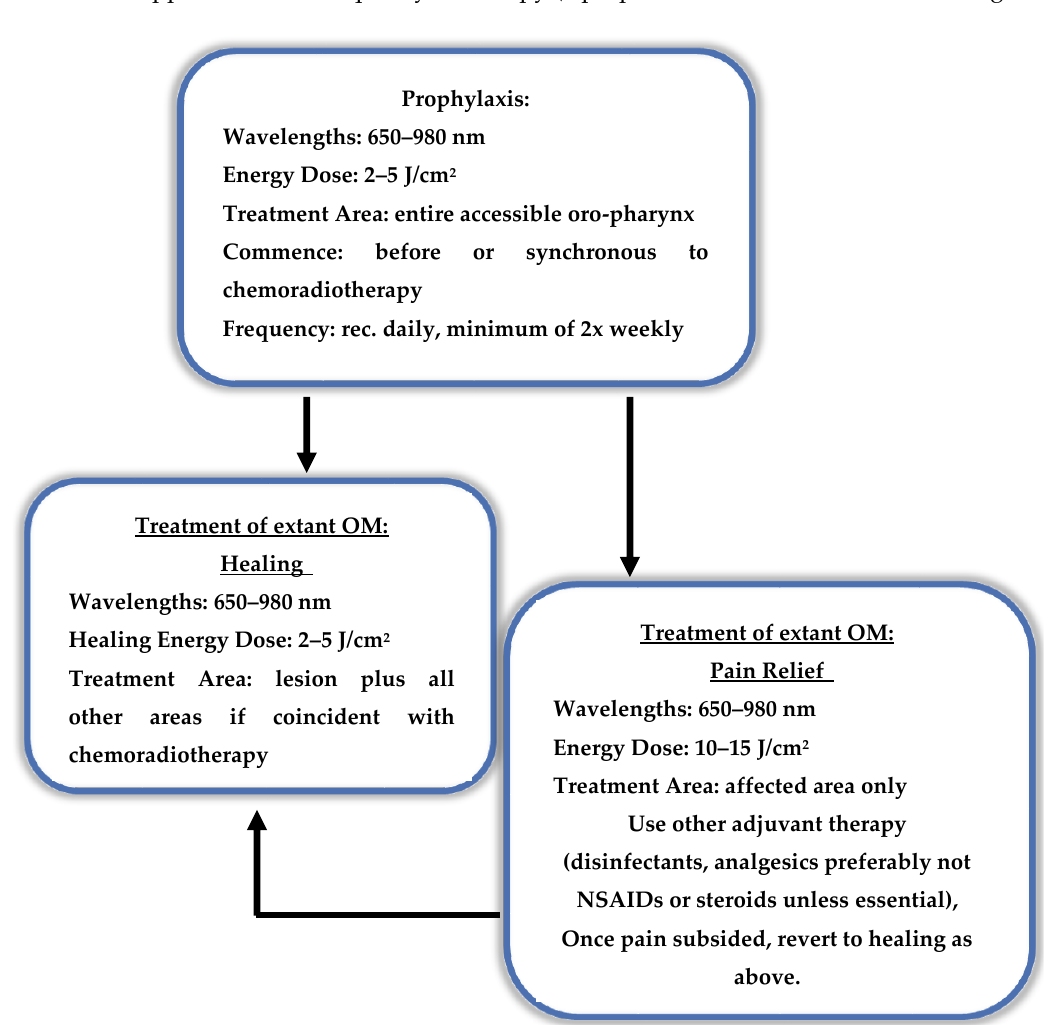
Figure 3. Proposed treatment decision tree—pain or healing? Outline of applied photobiomodulation (PBM) dose parameters to address the needs of pain relief and healing.